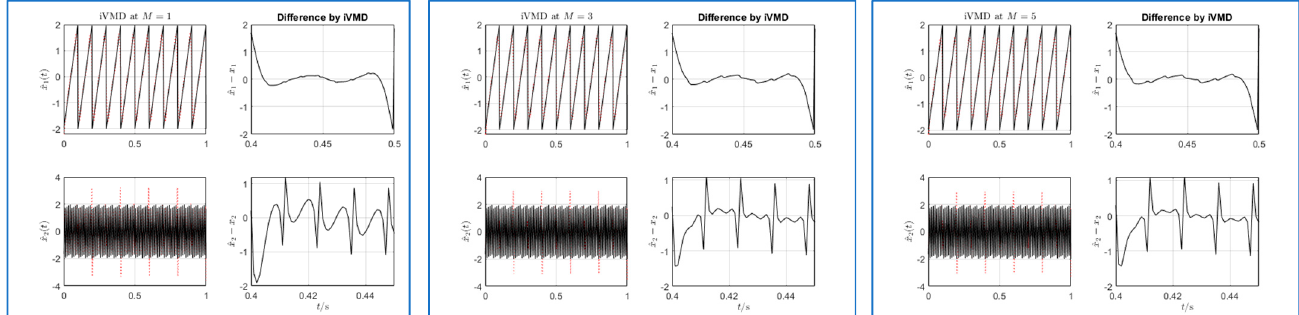
Figure 9. VMD decomposition of 𝑥 (cid:2903)(cid:2919)(cid:2917)(cid:2872) (𝑡) . 5.5. Example 5: An Electrocardiogram The fifth signal, 𝑥 (cid:2903)(cid:2919)(cid:2917)(cid:2873) (𝑡) , is an electrocardiogram (ECG). The data are shared by [2]. The data present numerous components in which there exists an oscillating low-frequency pattern, and a noise with a high frequency. Error! Reference source not found. illustrates the spectra and the results run via iVMD. A high number of 12 modes is detected. The